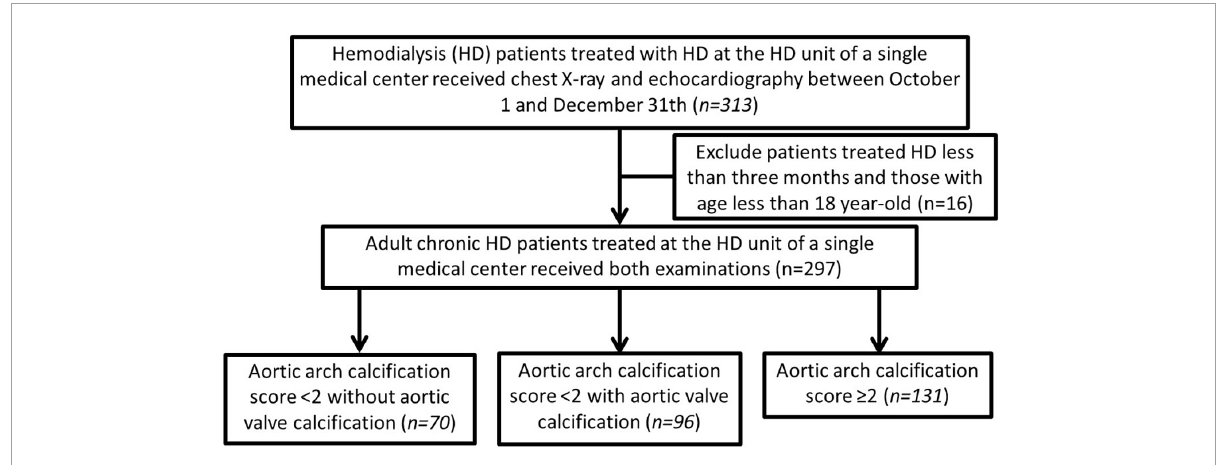
FIGURE1 The participant selection process in this